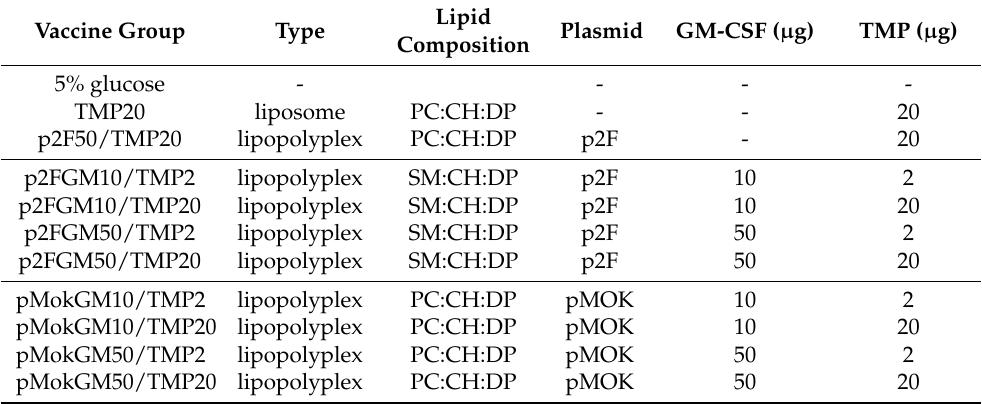
Table 1. Immunization assay groups with the multicompartmental lipopolyplex loaded with hy- drosoluble protein antigens (TMP).